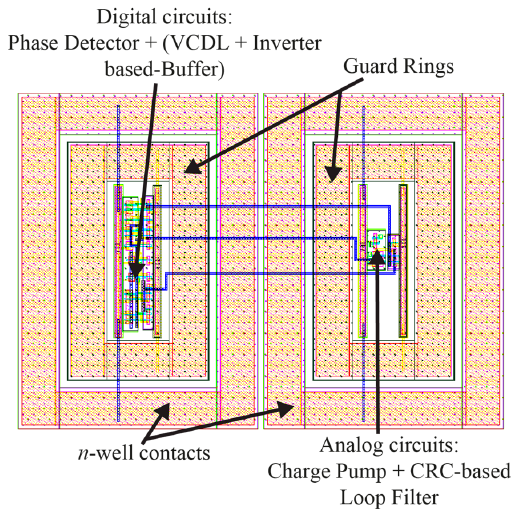
Figure 14. Layout of the proposed DLL.